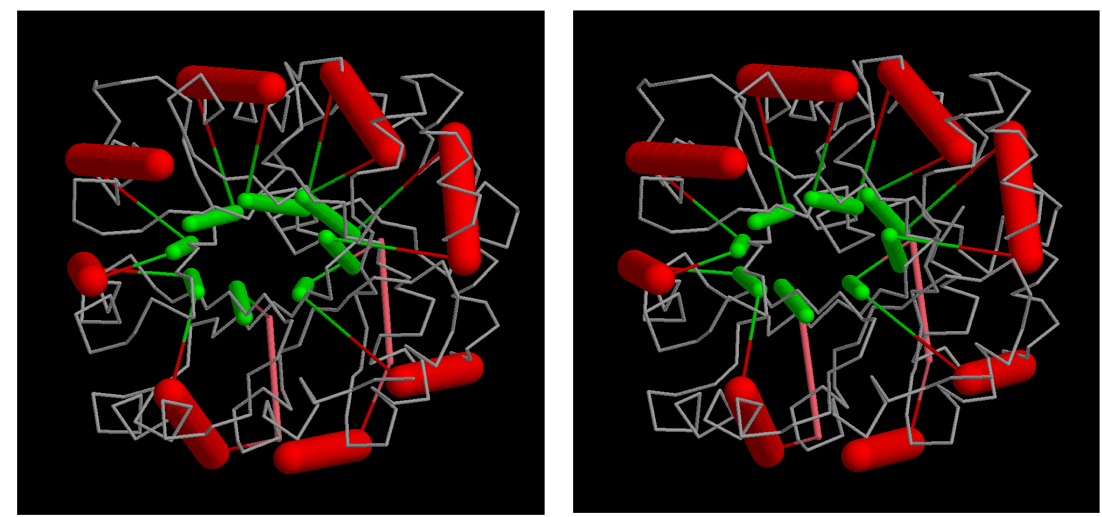
Figure 11. TIM in a triacontahedron: the beta/alpha barrel structure of triosephosphate isomerase (PDB:1timA) is mapped into the core of a triacontahedron. Although the SSEs are in roughly the right positions, their relative angles are not ideal. The parts comprise a “cross-eyed” stereo pair.